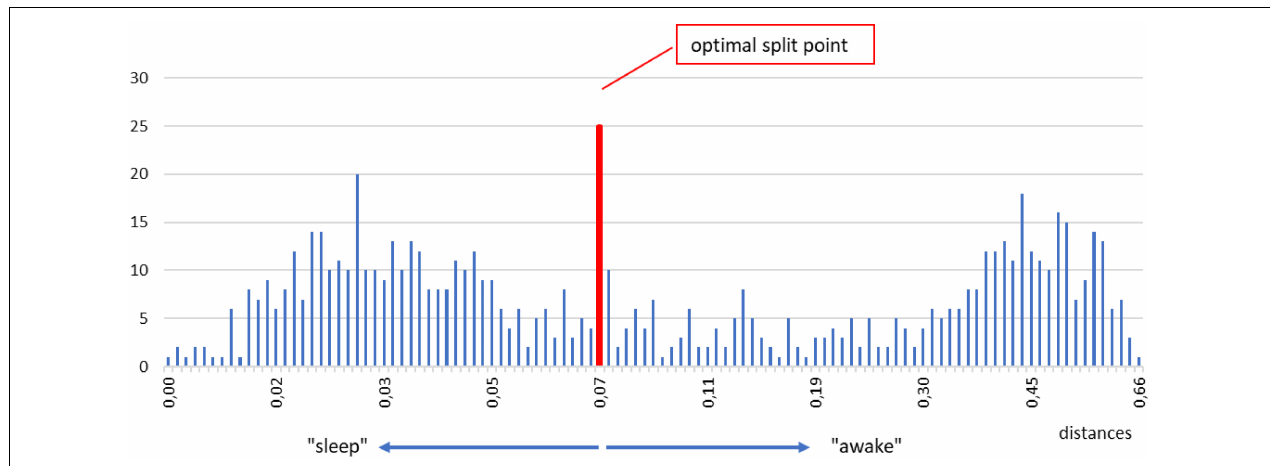
FIGURE 6 | Example of a histogram of all distances between the selected shapelet (taken from sleep, just for illustration) and all segments in a time series. Two main peaks mentioned in the text are visible, one for smaller distances, one for larger distances (denoted as “sleep” and “awake” for easier orientation). To find the optimal split point we test all tentative split points between each two histogram bins. We do so by computing the information gain corresponding to each tentative split point and choose the one that gives the best (maximal) information gain. The optimal split point for the histogram above is marked by a vertical red line. Segments whose distances are smaller (respectively, larger) than the optimal split point are defined as belonging to the first (respectively, second) class. After repeating this procedure for the entire pool of shapelets we define the best shapelet as the one, whose optimal split point gives the maximal information gain. We call this best split point and consider it the output of our method for determining the onset of